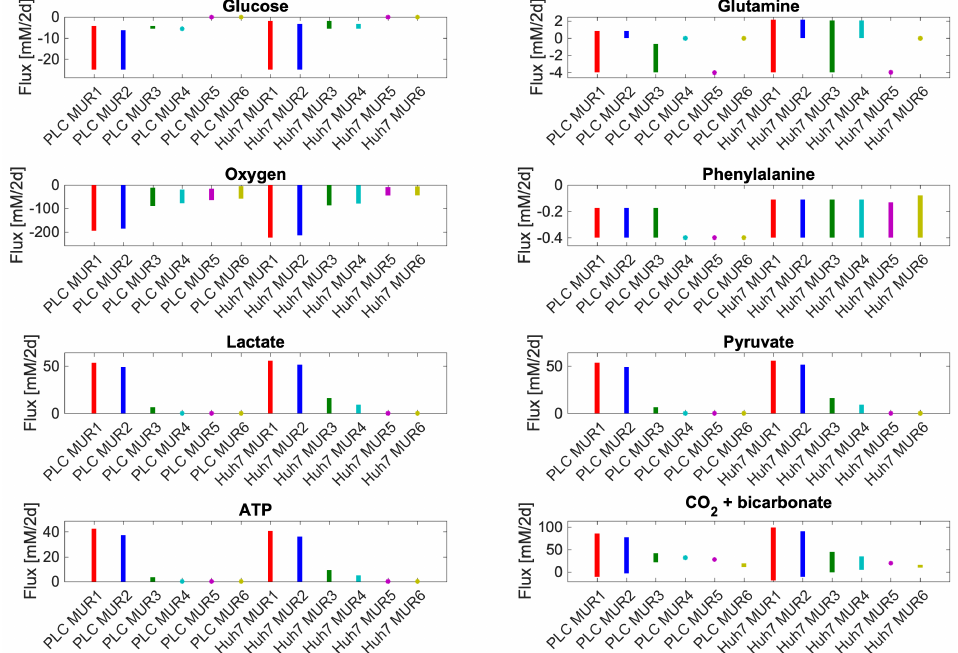
Figure 4. The range of uptake (if negative) / secretion (if positive) fluxes of various metabolites: computed to be consistent with maximal biomass flux and steady-state. Uptake and secretion fluxes of metabolites have units of mM/h. Since we set maximal uptake fluxes equal to medium concentrations these rates differ from reality by some undetermined factor which is identical for all conditions. Minimal and maximal exchange fluxes for each of the compounds lactate, phenylalanine, glutamine, pyruvate, oxygen (O 2 ) and CO 2 + bicarbonate and ATP hydrolysis flux (i.e., ATP + H 2 O => ADP + P i + H + ), were calculated using flux variability analysis [61] while requiring the model to produce the same maximum possible biomass fluxes shown in Figure 3. Maximal glucose and glutamine uptake fluxes had been set to their medium concentrations divided by 2 days (see Table 1 in Material and Methods). In these calculations, ATP is treated differently from the others. For the others, the reaction was and remained present and potentially carrying varying flux when any of the yet other fluxes was manipulated in the FVA. For the ATP, the ATPase reaction was absent (no growth rate-independent maintenance, therefore) when doing FVA for any of the others and only present when ATP synthesis was manipulated by forcing flux through an ATP hydrolyzing added reaction. For visibility, we used starred markers to indicate small flux ranges. These markers are typically located at minimal or maximal flux boundaries, e.g., zero glucose uptake in NA5 and NA6 or maximal phenylalanine uptake in PLC NA4. Uptake and secretion fluxes of metabolites have units of